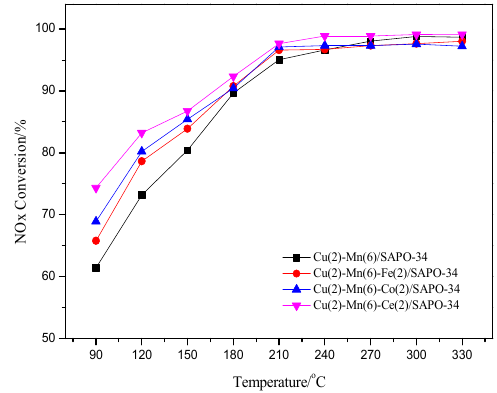
Figure 2. Changes of denitrification activity of Cu–Mn/SAPO-34 catalyst after modification of different transition metal additives. Reaction conditions: 350 ppm NO, 350 ppm NH 3 , 3% O 2 , N 2 balance, 500 ppm SO 2 (when used), and GHSV = 15,000 h − 1